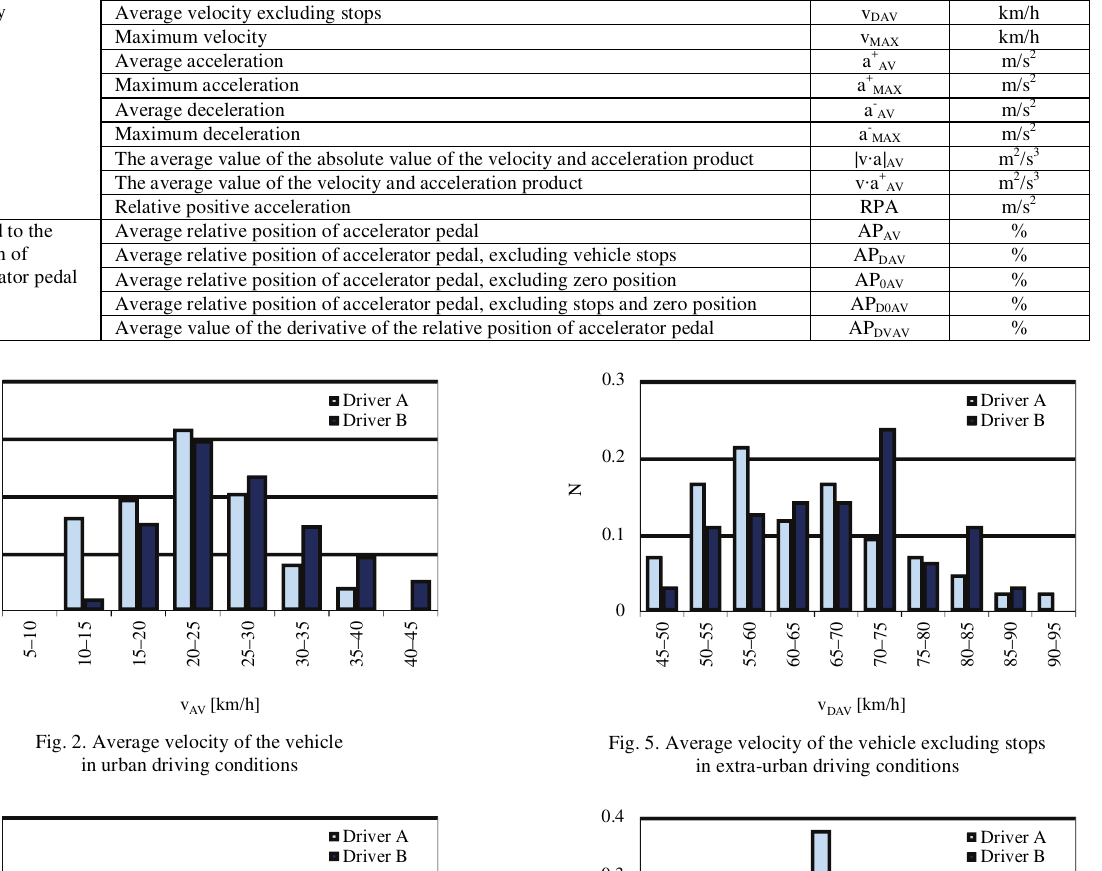
Fig. 6. Maximum velocity of the vehicle in urban driving conditions